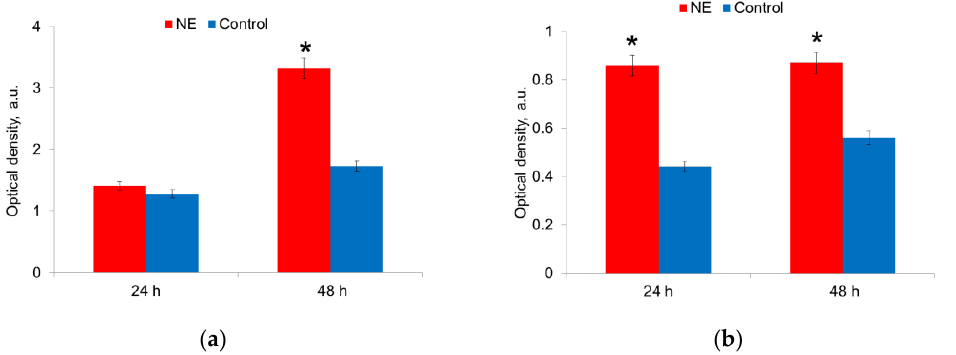
Figure 2. NE effect on biomass of E. coli ( a ) and S. aureus ( b ) cells in biofilm in 24 h and 48 h. * — statistically significant differences in comparison with the control without NE.